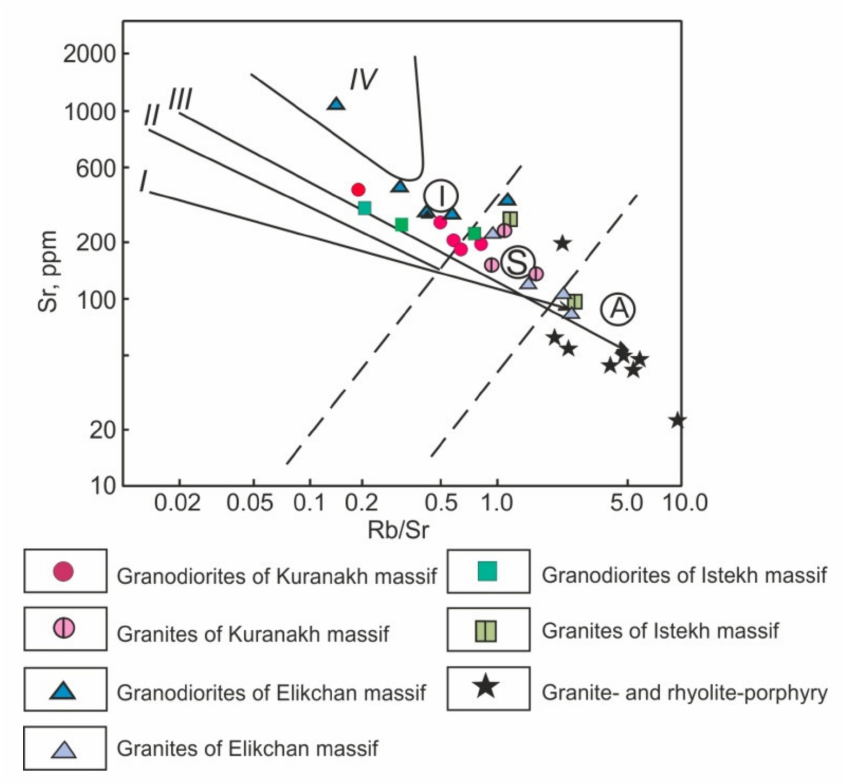
Figure 9. Sr–Rb/Sr diagram for granitoids. Differentiation trends of type series include [79]: I—island-arc tholeiitic; II—island-arc calcareous-alkaline; III—active margin calcareous-alkaline; IV—continental rift zones; and I, S, A—granitoid